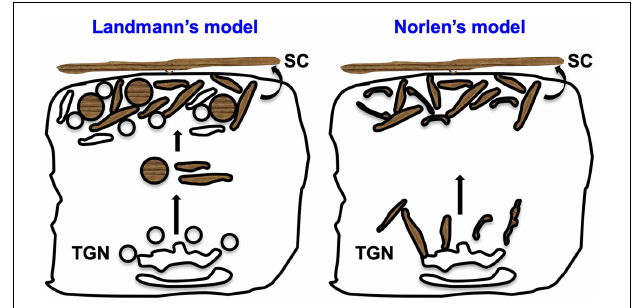
FIGURE 3 | Proposed models for lipid matrix formation at the SC. Landmann’s model: In the upper spinosum and granular layer keratinocytes, eLBs are bud off from the TGN as discrete vesicles/tubules. The cargo in these vesicles is packaged in the form of disks that avoid the enzyme activity during their transport. These vesicles fuse with the plasma membrane of the granular cells and release the disks between the SG-SC junction, which merge together and generate the lipid sheets of the corneum layer (Landmann, 1986; Norlen, 2001a). Norlen’s model: eLBs are the continuous tubulo-reticular network from TGN to the plasma membrane and multilamellar lipid matrix at the SG-SC junction. Further, these organelles secrete lipids through the intersection-free unfoldings at the plasma membrane invaginations of the granular cells (Norlen, 2001a). In both these models, keratinocytes of the SG secrete eLBs (either in the form of vesicles or tubules), which form the SC layer.